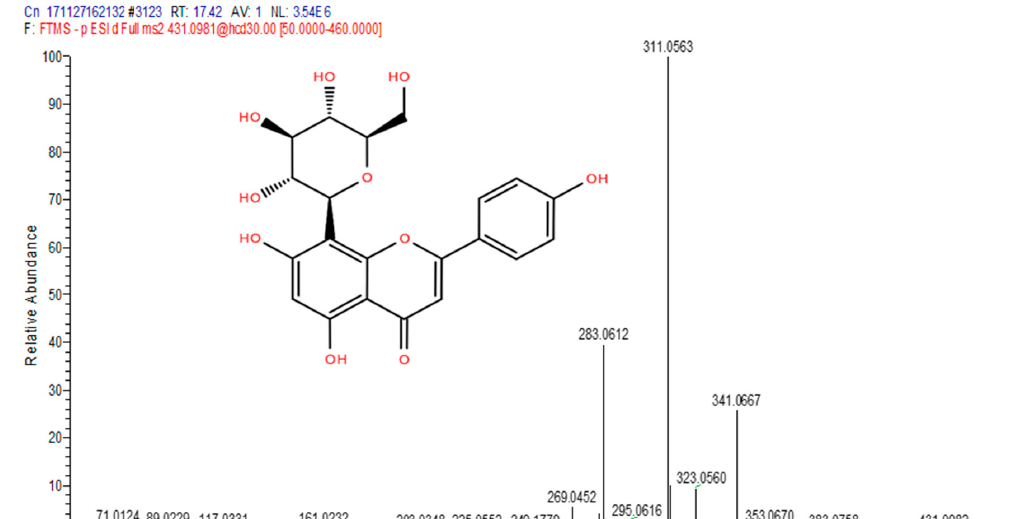
Figure 4. Isoorientin.